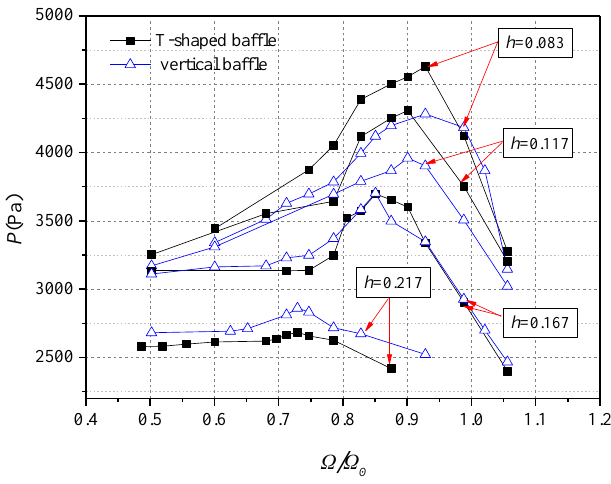
Figure 10. Comparisons of impact pressure under different heights of the T-shaped baffle.